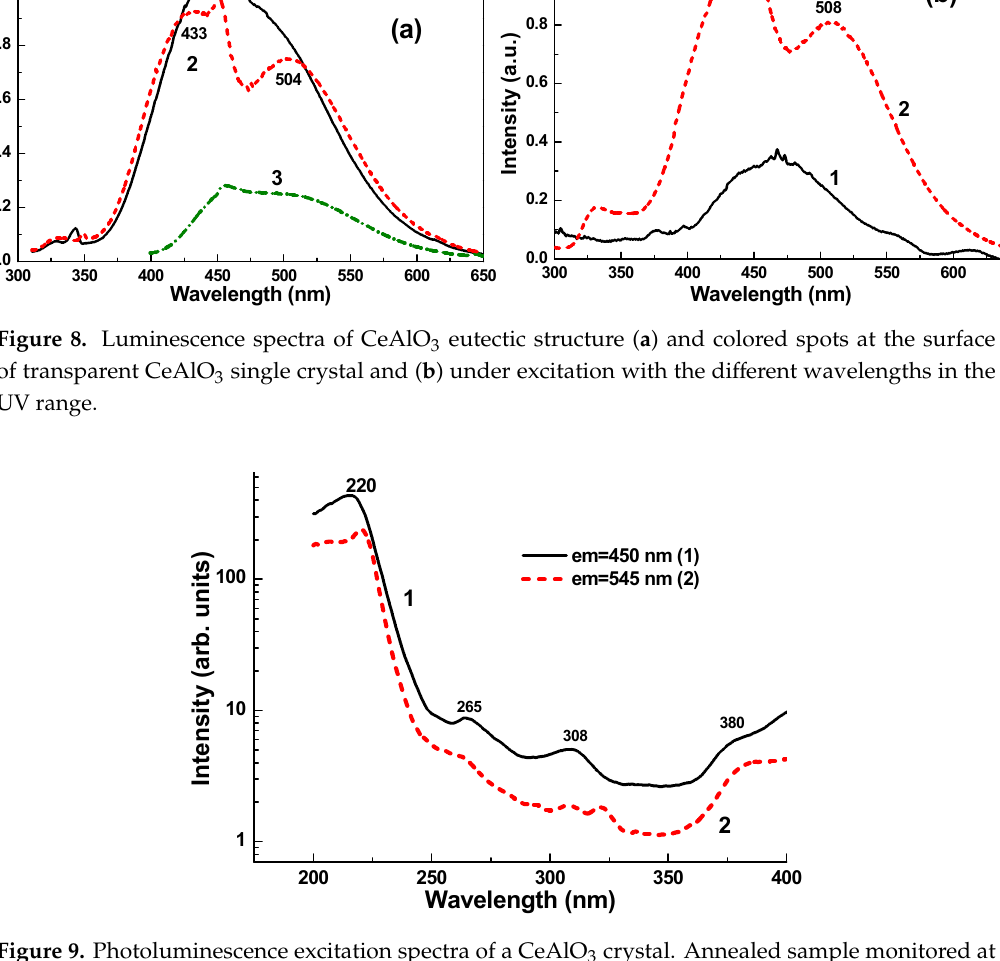
Figure 9. Photoluminescence excitation spectra of a CeAlO 3 crystal. Annealed sample monitored at 450 nm ( 1 ) and annealed CeAlO 3 crystal monitored at 545 nm ( 2 ).